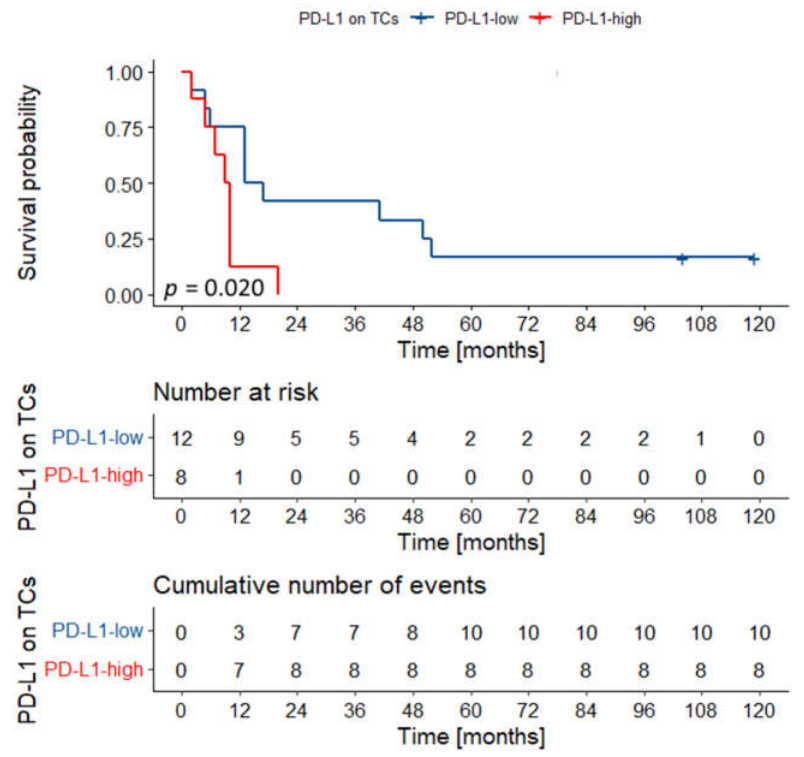
Figure 5. Overall survival probability curve according to PD-L1 expression on TCs in T3–T4 tumors of the tongue/floor of the oral cavity. Tumors with high PD-L1 expression on TCs had dismal outcomes. p value was calculated with the log-rank test. Abbreviations: TCs—tumor cells.